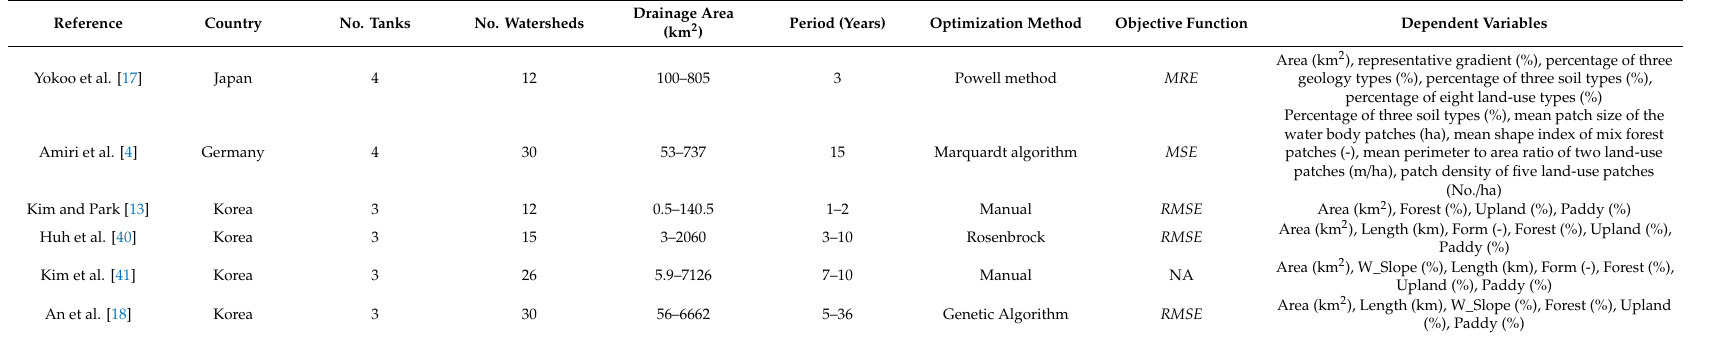
Table 2. An overview of previous studies related to the regionalization of Tank